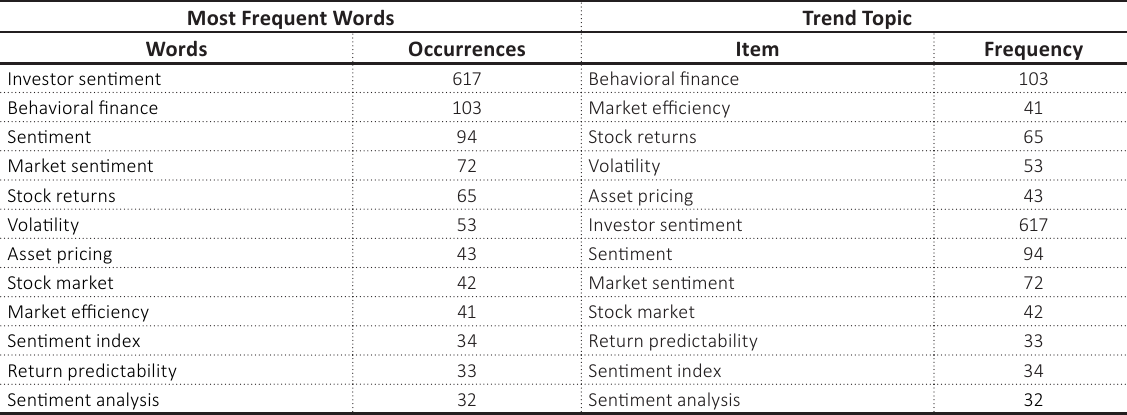
Table 6. Top 20 most frequently used author keywords associated with investor sentiment